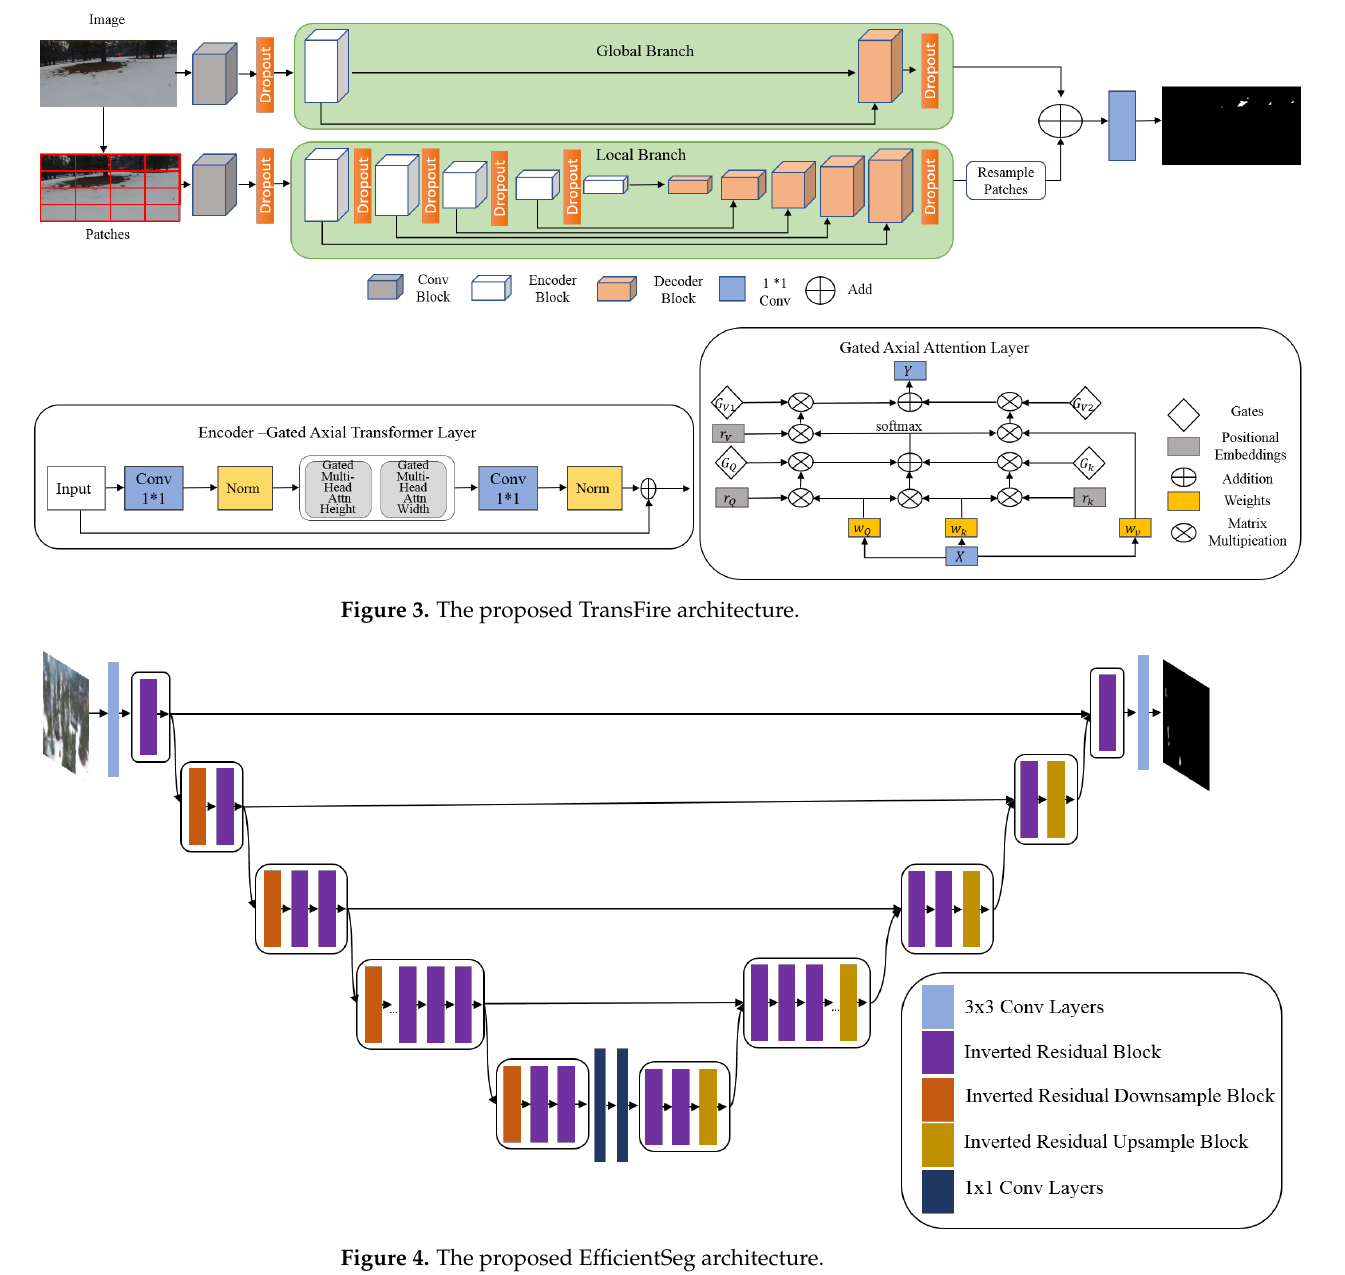
Figure 4. The proposed EfficientSeg